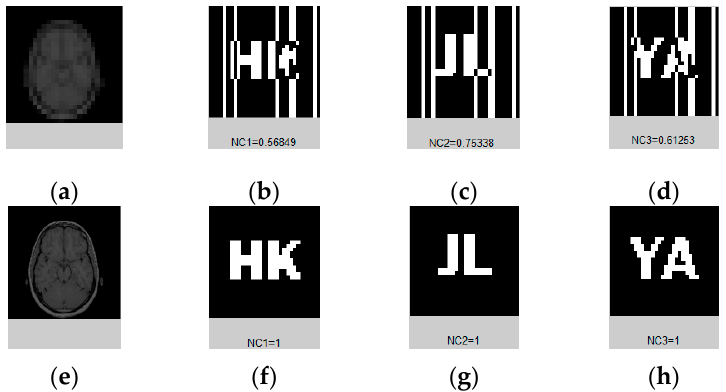
Figure 19. Under scaling attacks: (a) Scaling factor 0.2; (b) the extracted watermark 1 under scaling